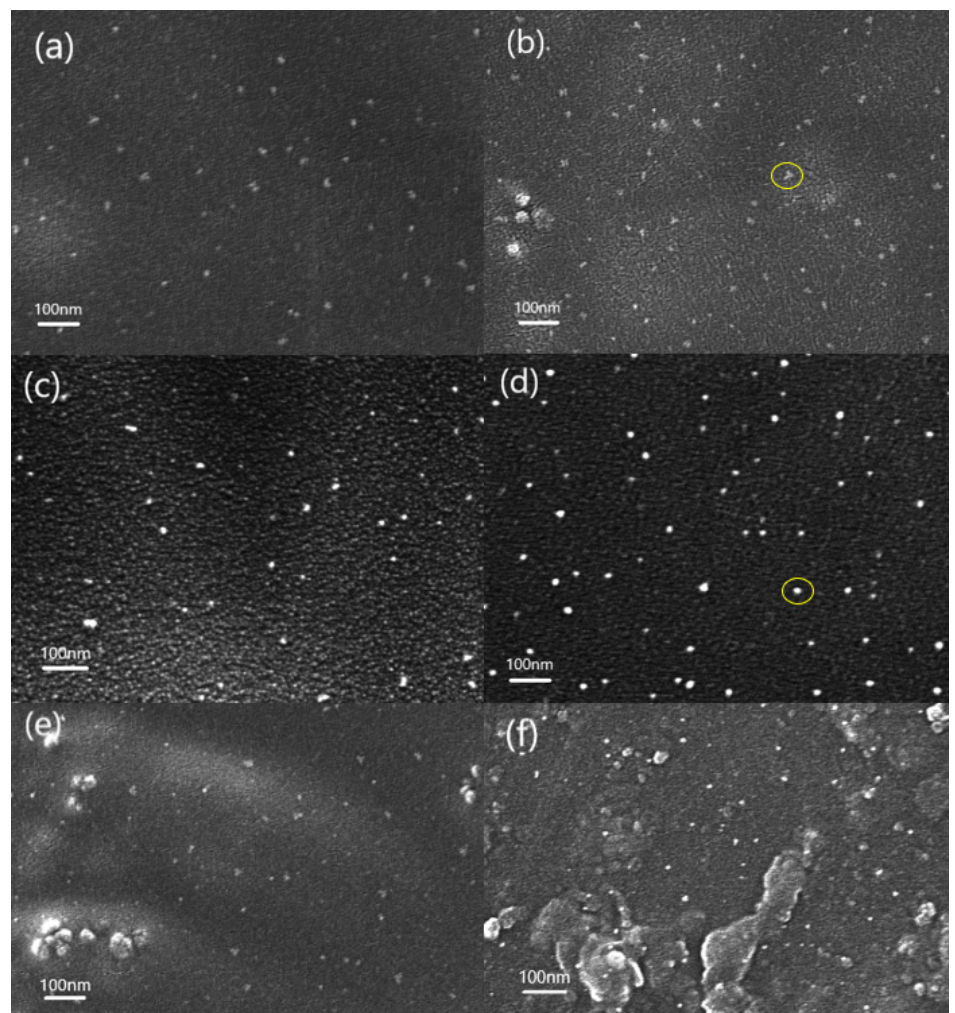
Figure 2. SEM images of PIS05 ( a ), PIS10 ( b ), PIS20 ( e ) and PIS30 ( f ) with KH560 coupling agent, PIS05 ( c ) and PIS10 ( d ) without KH560 coupling agent.